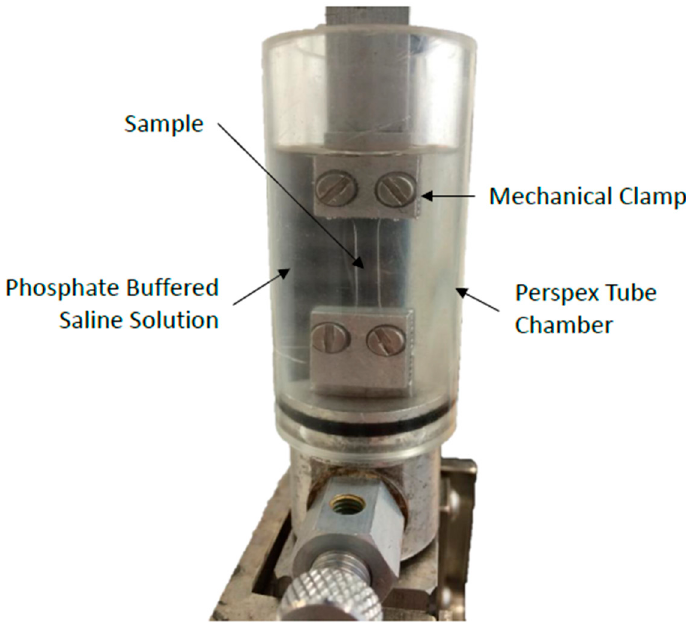
Figure 2. Setup used for the tensile testing of the hydrogel materials.